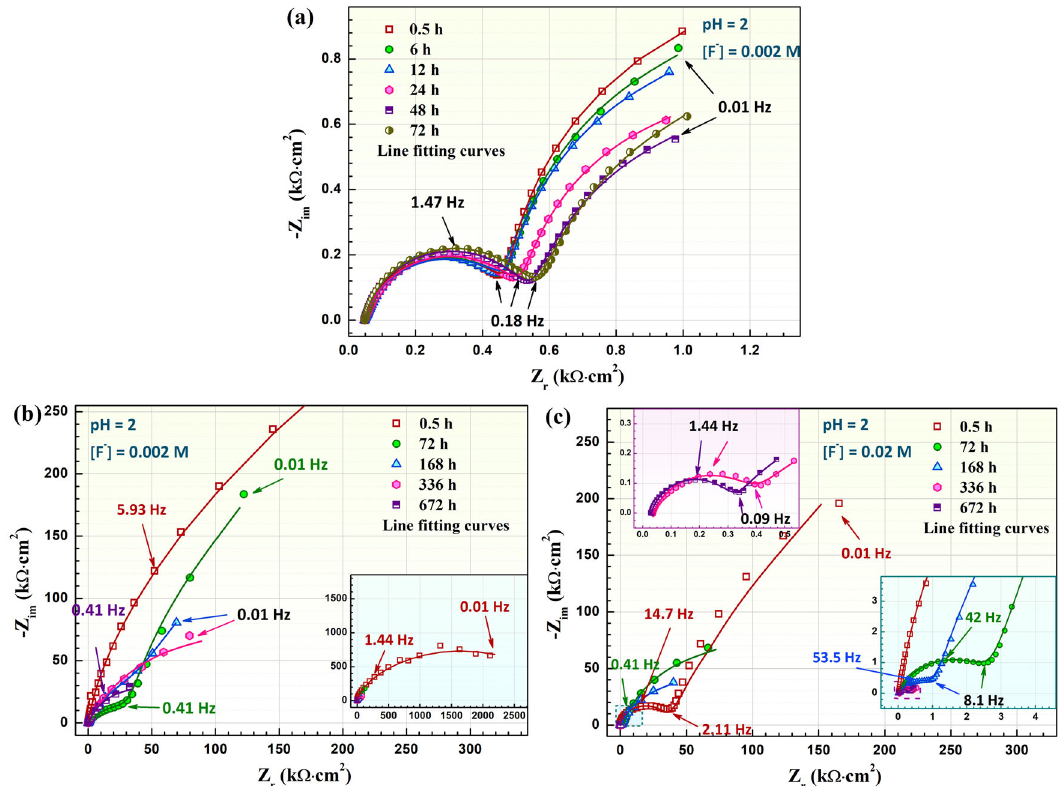
Fig. 7 EIS after immersion in the fl uoride-containing H 2 SO 4 solutions (pH = 2) for different time. Nyquist diagram of the as-received pure Ti after immersion in 0.002 M fl uoride-containing solution for 72 h a , and Nyquist diagrams of the thermally oxidized pure Ti (at 650 °C for 24 h) during immersion in 0.002 M b and 0.02 M c fl uoride-containing solutions for 672 h. The corresponding Bode diagrams can be found in Supplementary Fig. 4 in the supporting